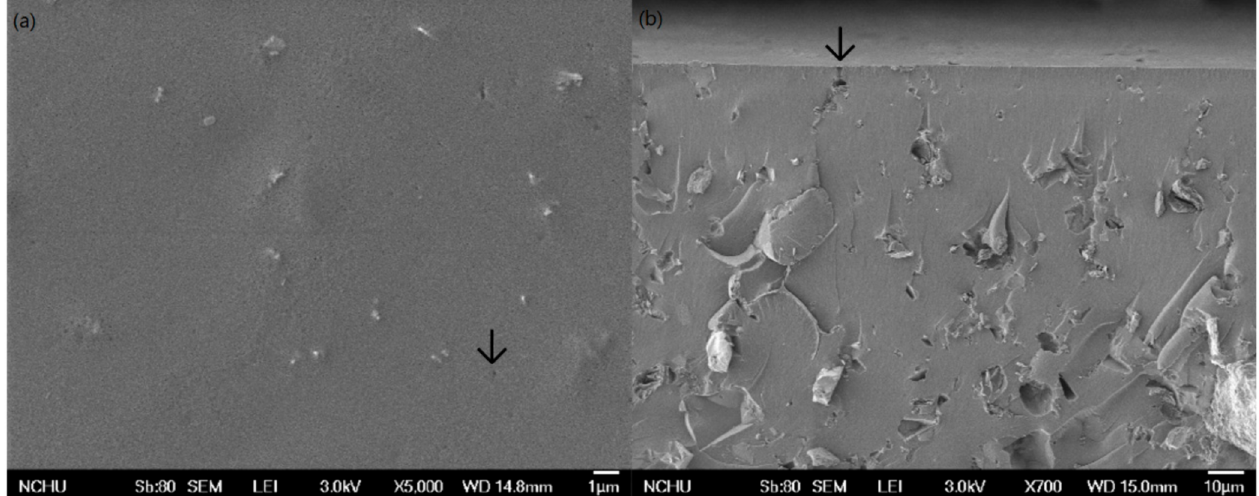
Figure 5. The FE-SEM inspection of UV film surface ( a ) and profile with 12-phr Zn(HEEP) 2 addition ( b